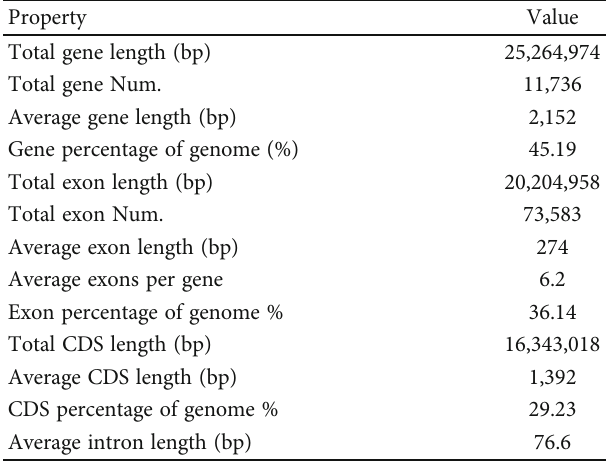
Table 2: Prediction of genes in the assembled H. coralloides genome.